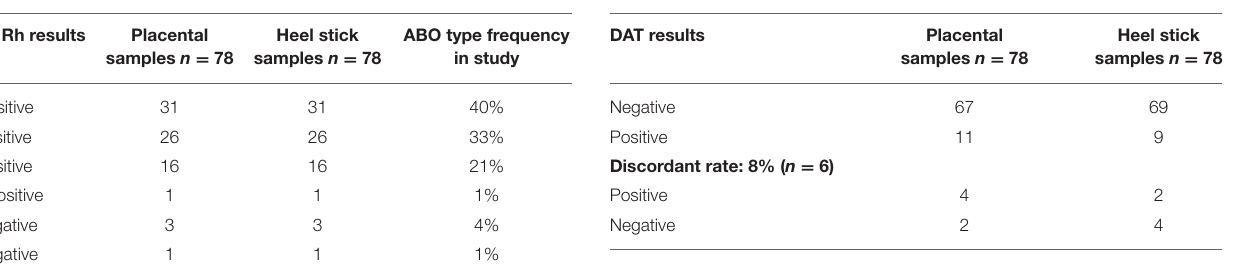
TABLE 1 | ABO and RH test results. TABLE 2 | DAT test